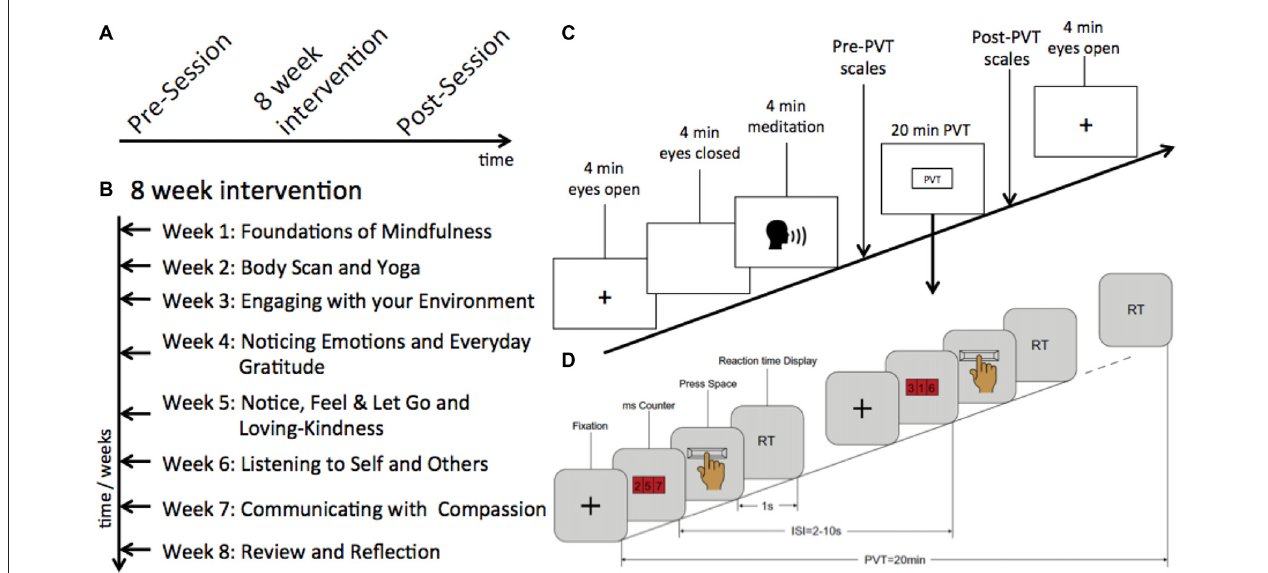
FIGURE 1 | Schematics of data collection and the mindfulness-based training (MBT) program. (A) Sequence of sessions attended by participants. (B) The theme of each of the intervention sessions. (C) Sequence of blocks of electroencephalography (EEG) data collection across sessions. (D) Schematic of the psychomotor vigilance task (PVT)